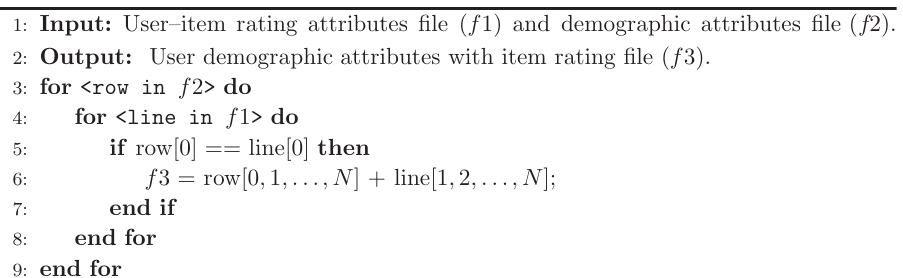
Algorithm 3.1. Proposed algorithm